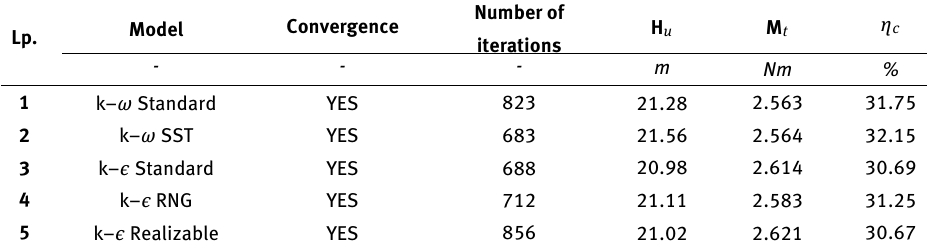
Table 2: Influence of the turbulence model